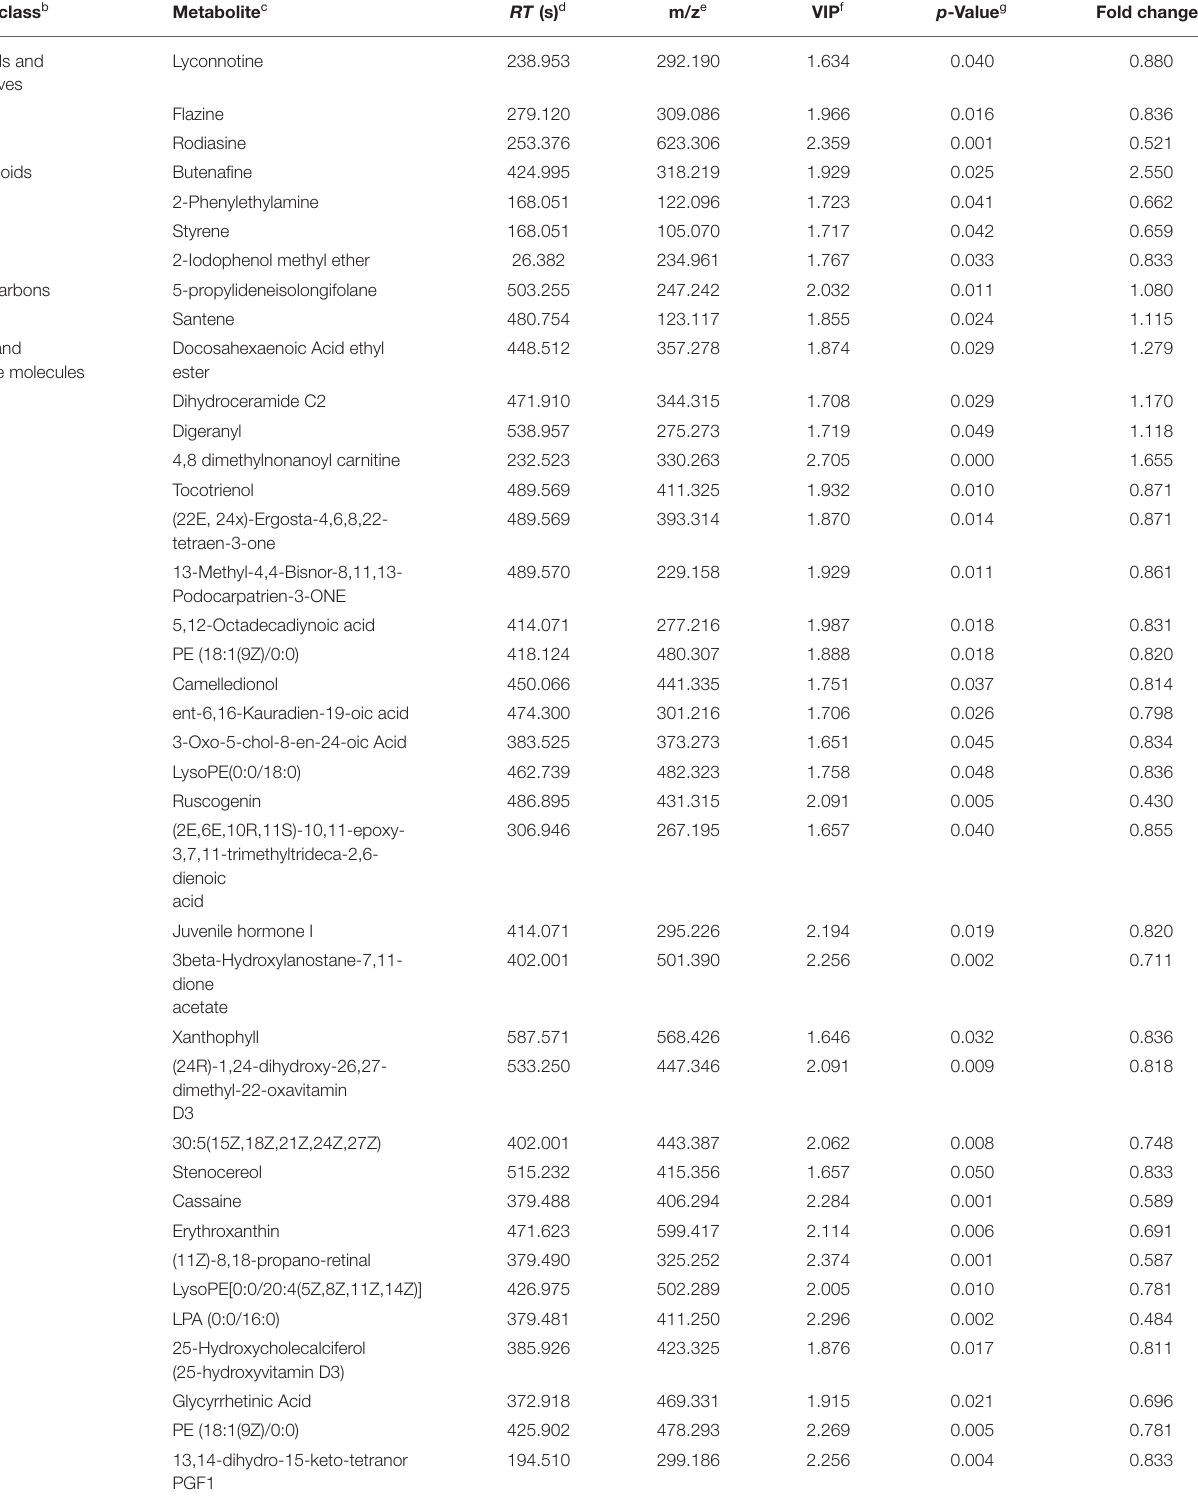
TABLE 8 | HMDB compound classification of differential metabolites of feces between NCG group and CON group a . Super class